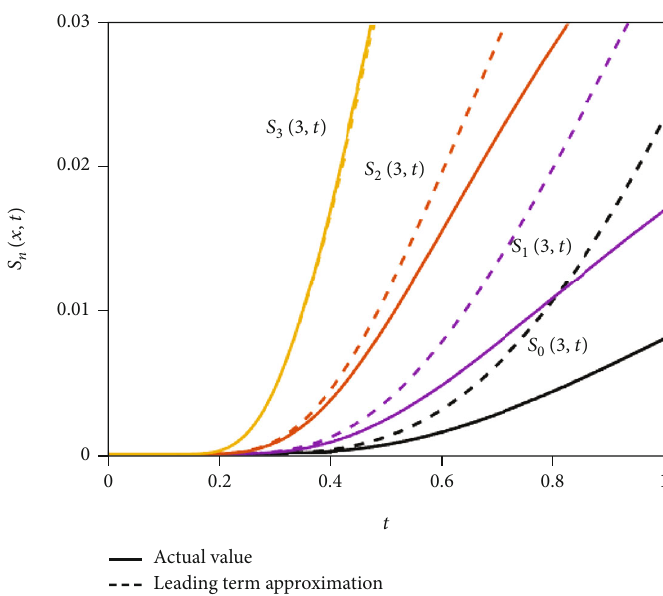
Figure 3: Leading term approximation for t ⟶ 0 +